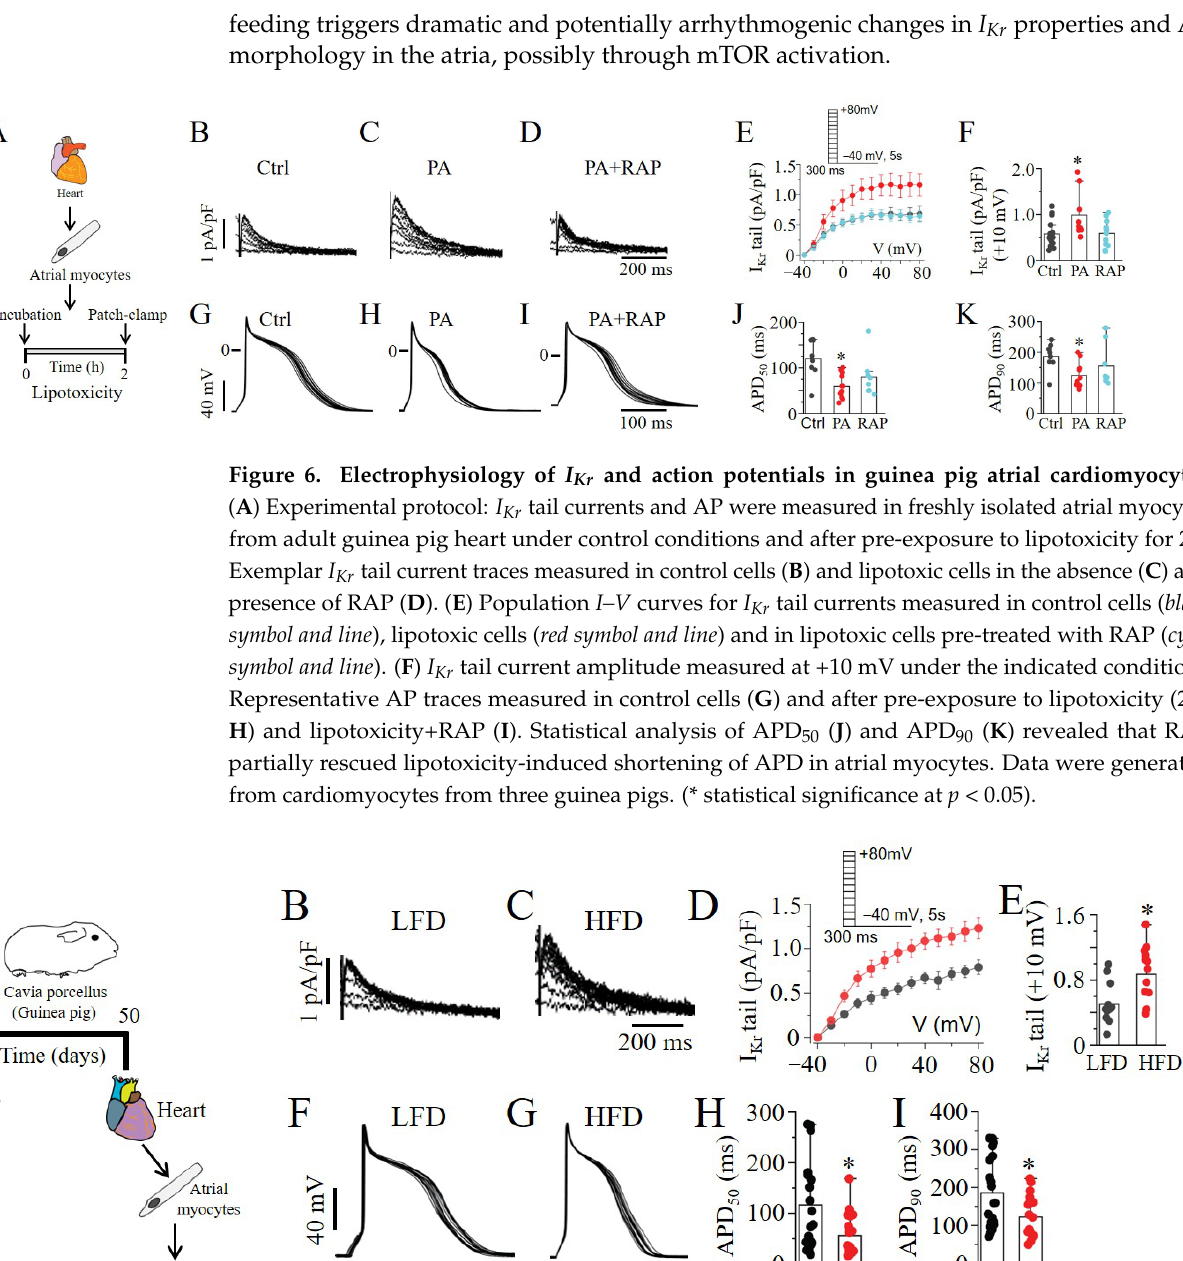
Figure 7. High-fat-diet feeding upregulated I Kr and shortened action potential duration in adult guinea pig atria. ( A ) Experimental protocol: I Kr tail current density and APs were measured in guinea pigs fed an LFD or HFD for 50 days. ( B – E ) Exemplar I Kr tail current traces, population I peak – V, and averaged current amplitude at +10 mV measured in freshly isolated atrial myocytes. Pooled I–V curves (in D ) represent I Kr tail current density measured in LFD-fed control myocytes ( black symbol and line ) and HFD-challenged myocytes ( red symbol and line ). ( F – I ) Current-clamp analysis of AP morphology in atrial myocytes from LFD- and HFD-fed guinea pigs. Electrophysiology data were generated from cardiomyocytes from three guinea pigs per diet group. (* statistical significance at p <